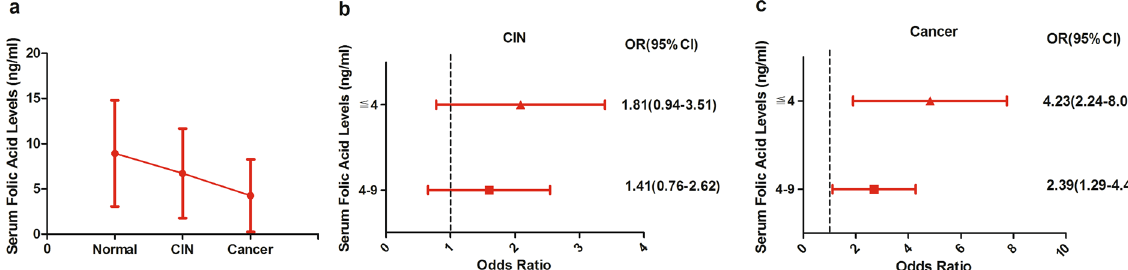
Figure 4. Efficacy of folic acid with risk of cervical cancer. ( a ) the expression levels of serum folic acid in the normal group, CIN group and cancer group, respectively, ( b ) serum folic acid levels associated with CIN, ( c ) serum folic acid levels associated with cervical